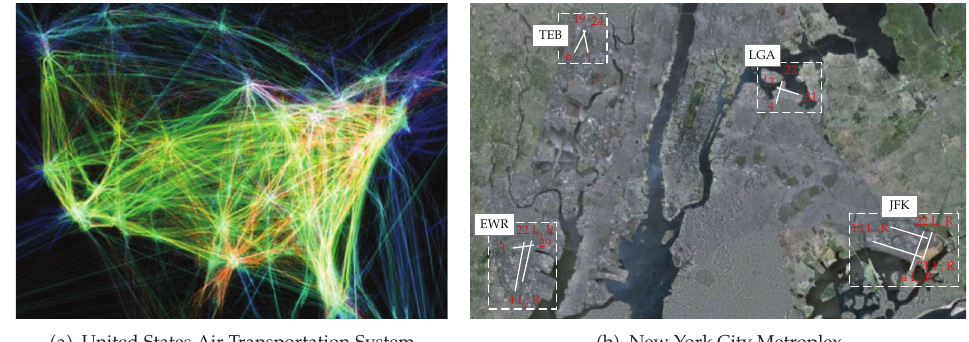
Figure 1: Components of the Air Transportation